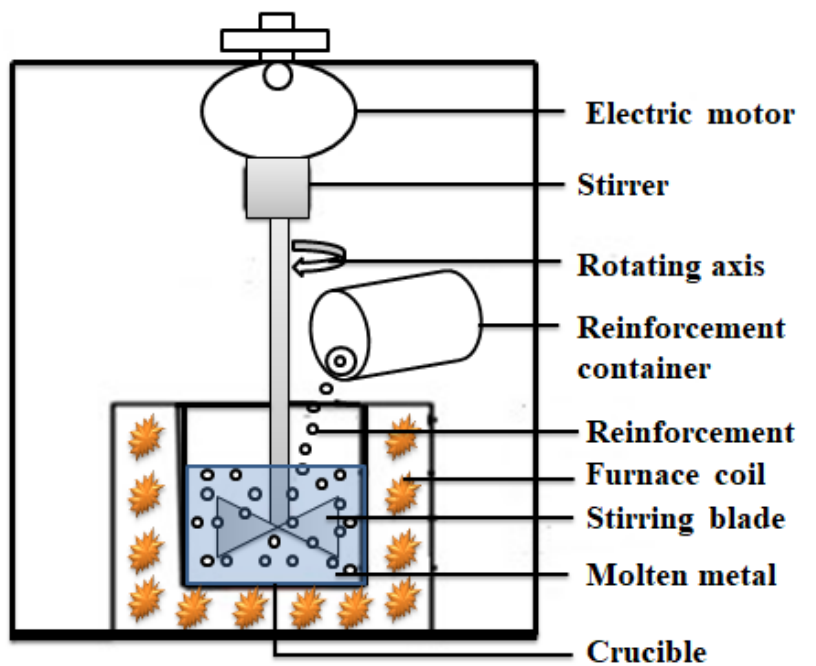
Figure 6. Schematic Image of Stir-Casting Process, Adapted and Redrawn From [68].